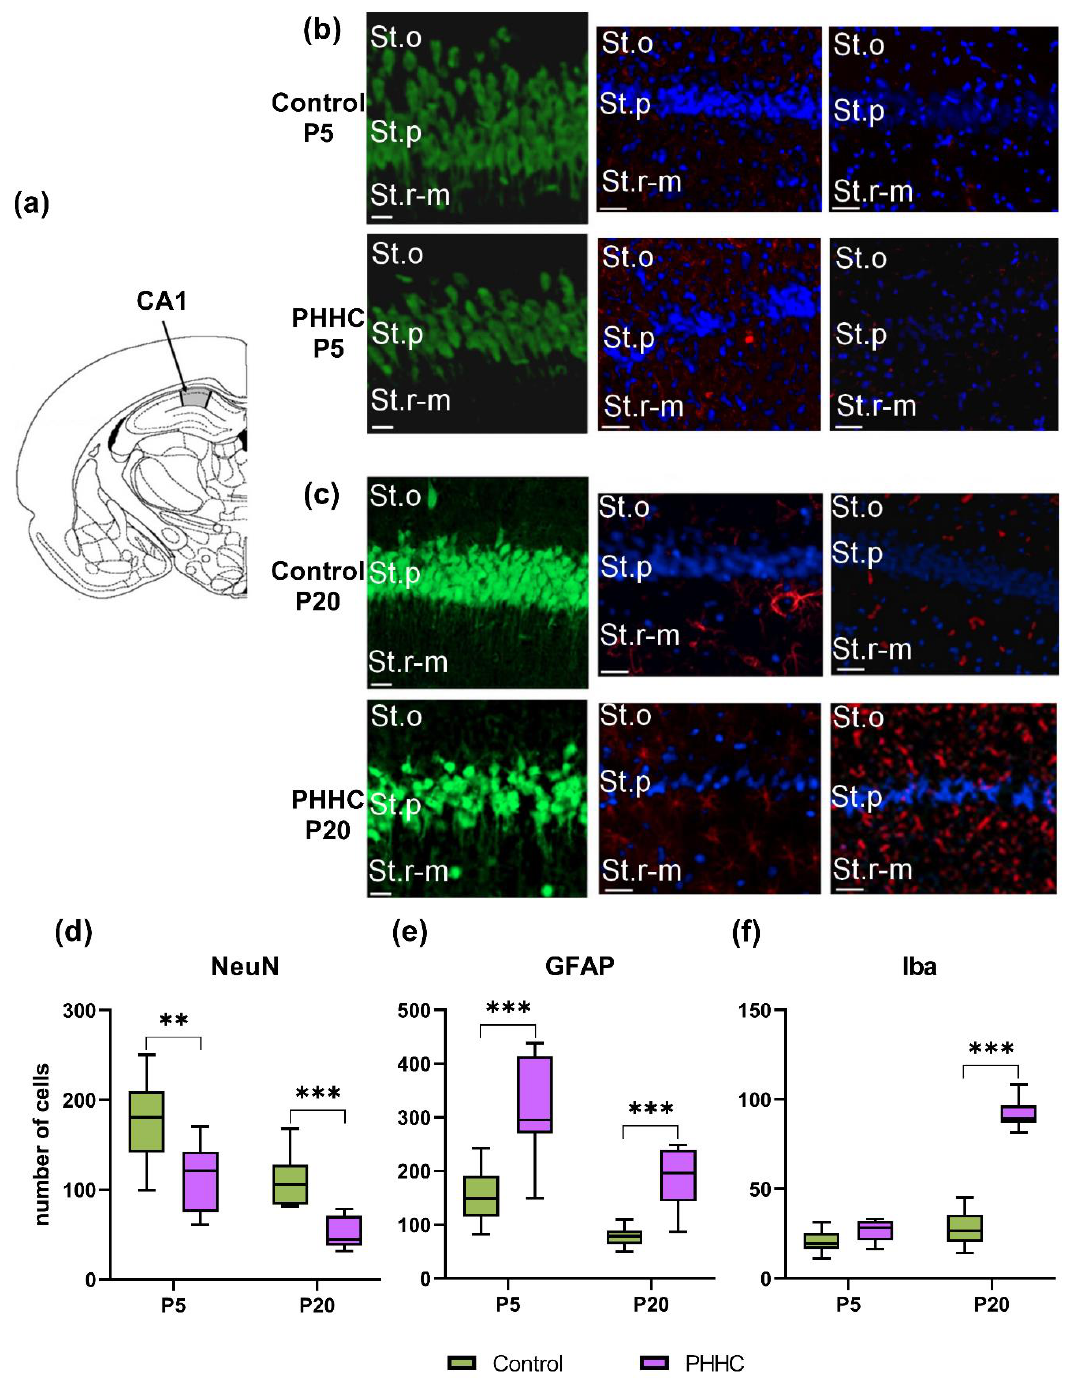
Figure 3. The effect of prenatal hyperhomocysteinemia (PHHC) on the number of neuronal and glial cells in the CA1 area of the dorsal hippocampus. ( a ) The scheme of the analyzed area in the hippocampus (gray shading). ( b ) Micrographs of the CA1 area of P5 control pups and pups subjected to PHHC. ( c ) Micrographs of the CA1 area of P20 control pups and pups subjected to PHHC. Immunohistochemical staining of neuronal marker protein NeuN (FITC, left), marker of astrocytes GFAP (PE, in the middle), or microglial marker Iba1 (PE, right). Cell nuclei were stained with non-specific nucleus dye DAPI (blue). Scale: 40 µm. The median number of cells in the hippocampus: NeuN-positive neurons ( d ), GFAP-positive ( e ), and Iba1-positive ( f ) glial cells in control pups ( n = 8) and rats after PHHC ( n = 8). Values are expressed as Me (25th, 75th percentile), whiskers—min-max. Significance of difference between the PHHC and control groups were determined by the Mann–Whitney U test (** p ≤ 0.01, *** p ≤ 0.001). St.p, stratum pyramidale; St.o, stratum oriens; St.r-m, stratum